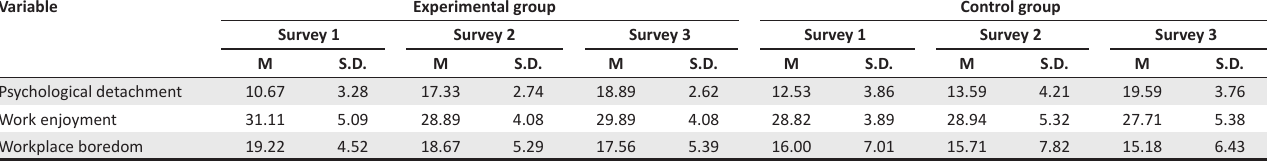
TABLE 4: Group mean scores and standard deviations. Variable